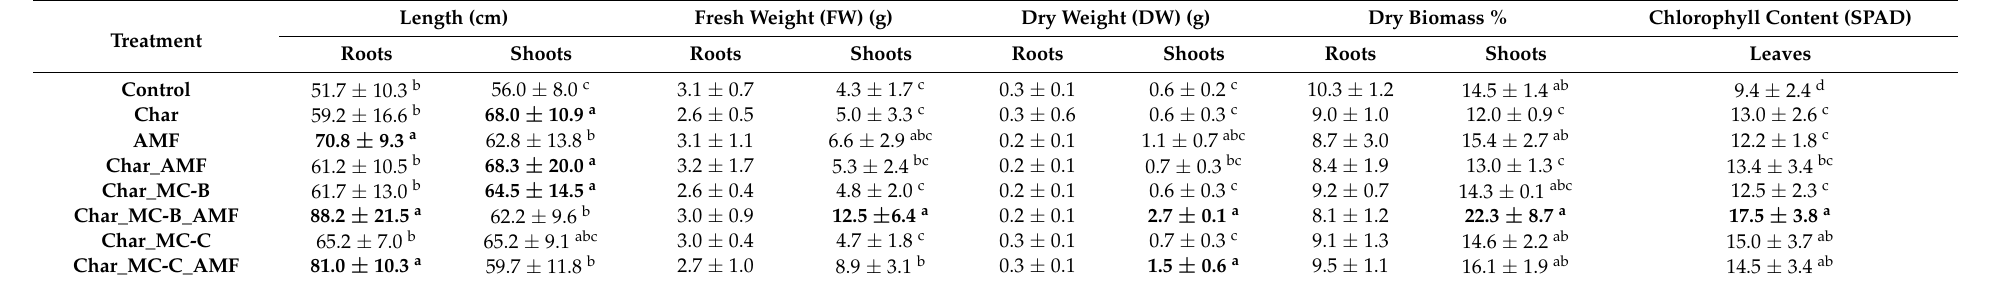
Table 2. Measurements of the physiological parameters analyzed for maize shoots and roots when subjected to treatments as indicated. For each trait, the mean value and standard deviation are